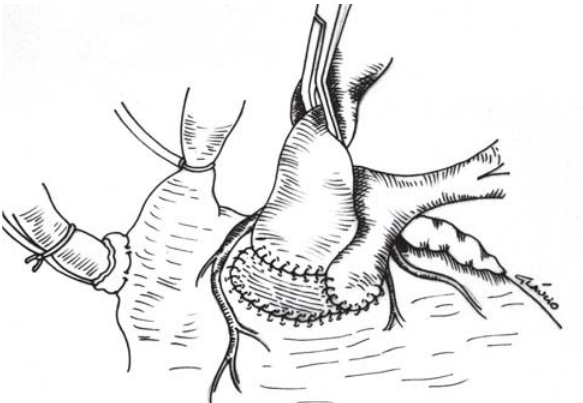
Fig. 3 - O orifício resultante da retirada da translocação aórtica foi parcialmente fechado à direita com um enxerto de pericárdio autólogo fresco. A aorta ascendente com as artérias coronárias e saída do ventrículo